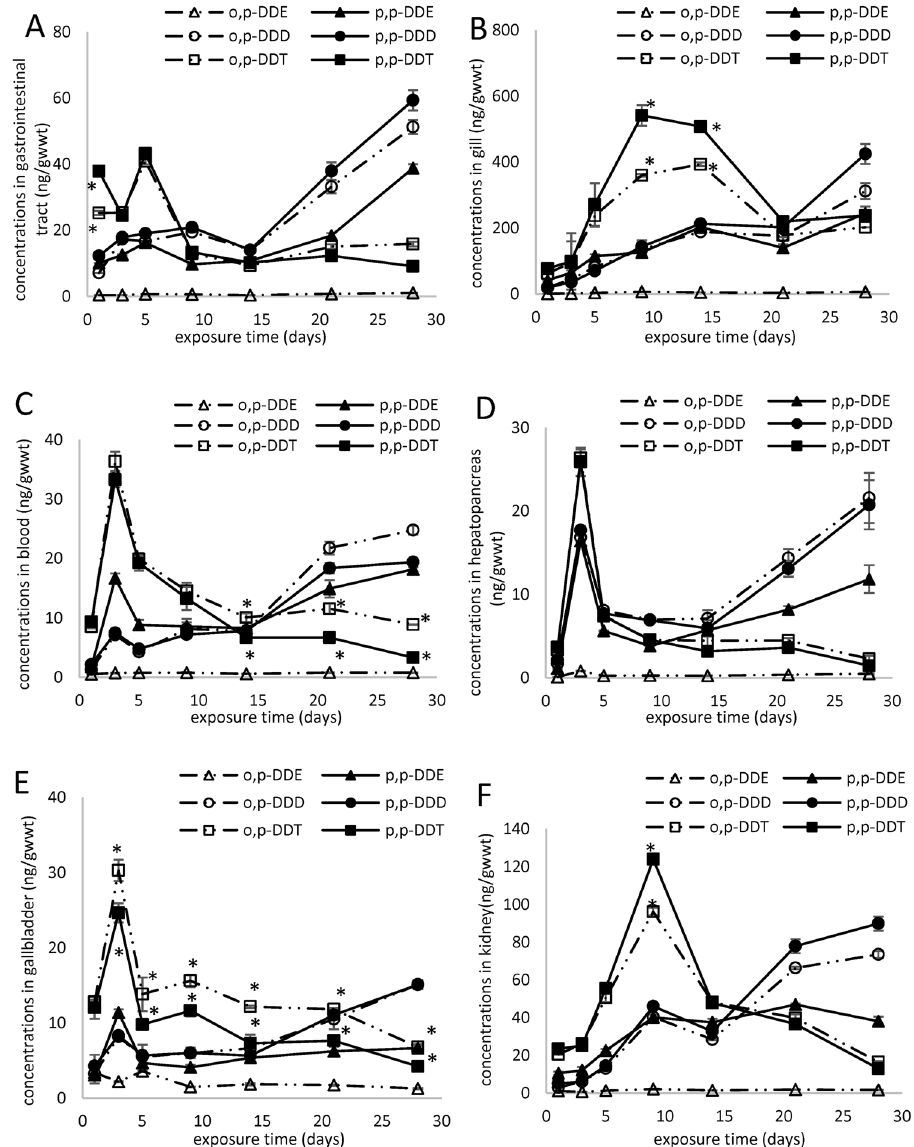
Figure 2. The accumulation of DDTs in gastrointestinal tract ( A ), gill ( B ), blood ( C ), hepatopancreas ( D ), gallbladder ( E ) and kidney ( F ) in carp in the treatment group. * Indicates significant difference between p,p’- DDT and o,p’-DDT ( p < 0.05, S-N-K